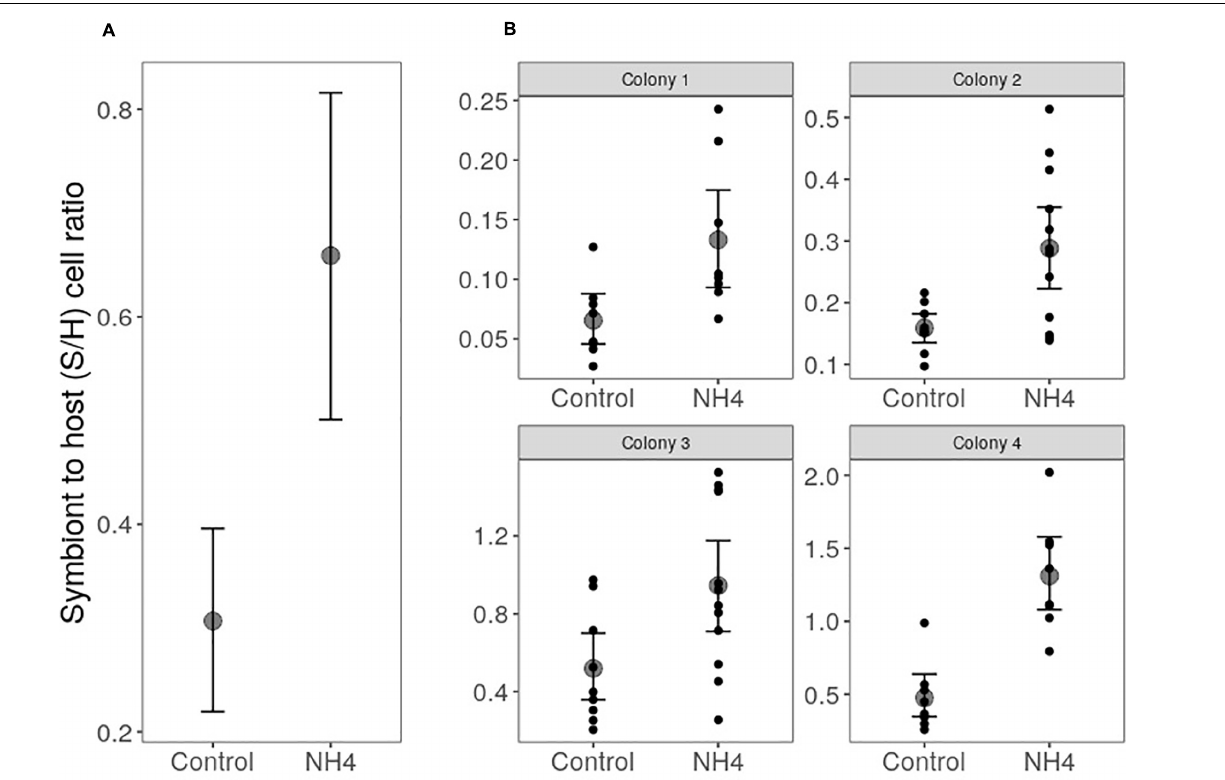
FIGURE 1 | Effect of ammonium enrichment on O. faveolata symbiont to host (S/H) cell ratio (mean ± 95 CI) across. Two-way ANOVA revealed higher S/H cell ratios in corals exposed to elevated ammonium ( p < 0.001; A ), regardless the differences in the S/H cell ratio among coral colonies ( p < 0.001; B ). Letters represent significantly different groups obtained with Tukey’s HSD test (alpha = 0.05). Statistical analysis was performed on log 10 transformed S/H cell ratios to increase normality of the data, but graphs show untransformed values.